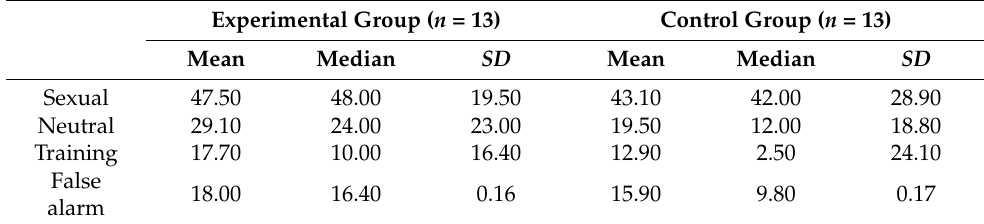
Table 2. Picture recognition task: Mean hit rates (%), Median, and SD .